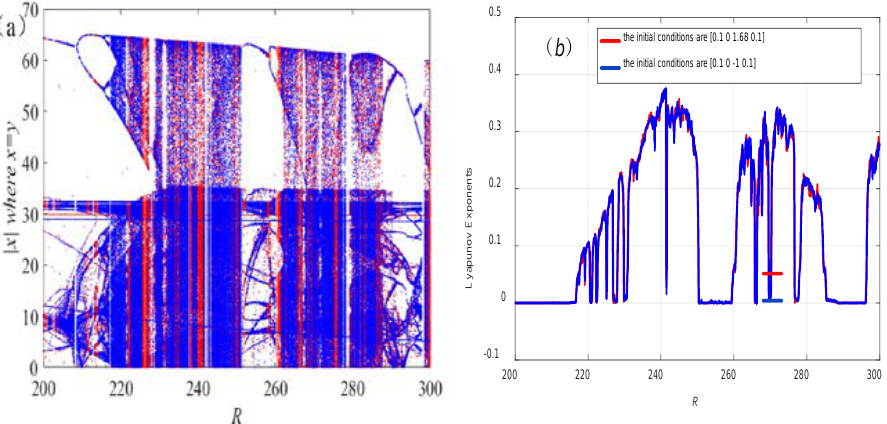
Figure 9. The enlargement of Figure 8 ( R ∈ [200, 300]): ( a ) bifurcation diagram, ( b ) largest Lyapunov exponent.